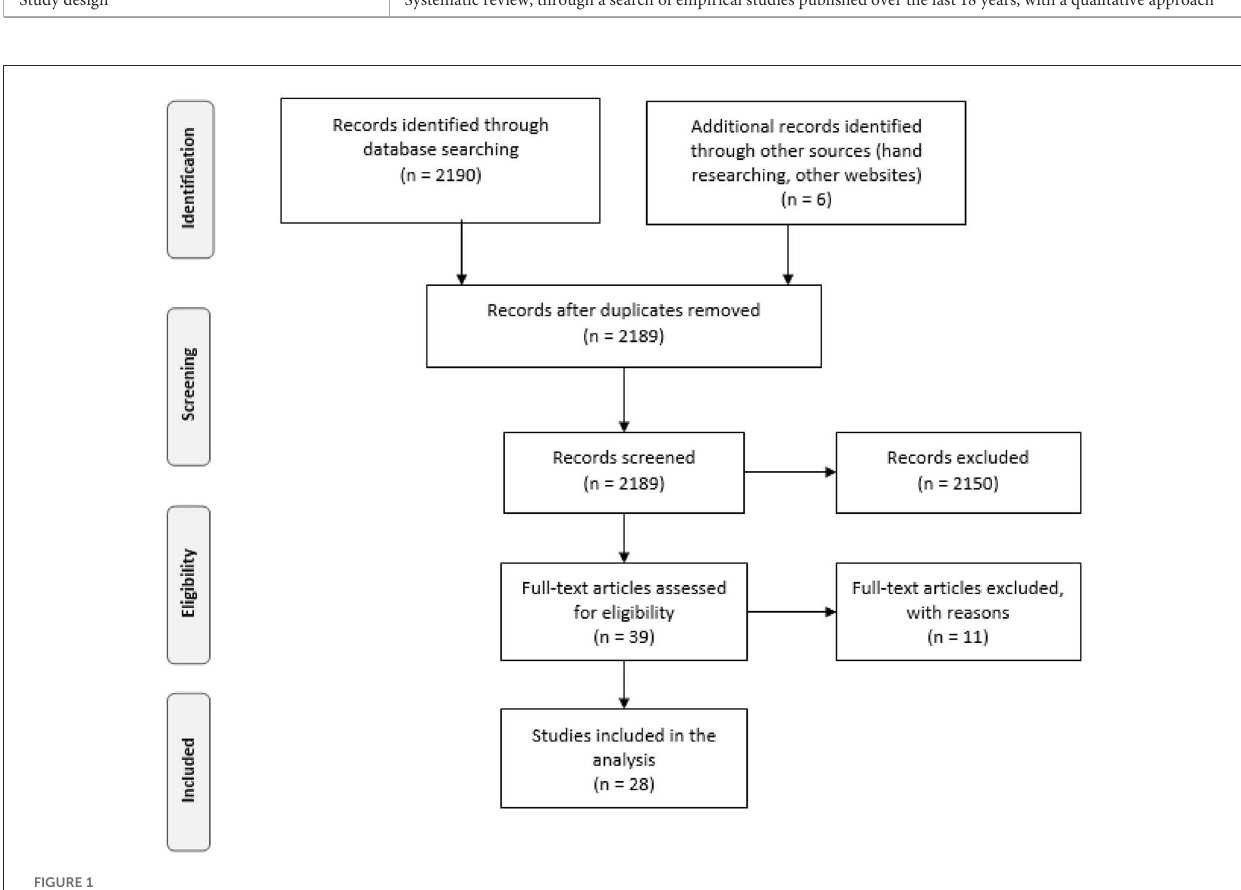
FIGURE1 PRISMA flow